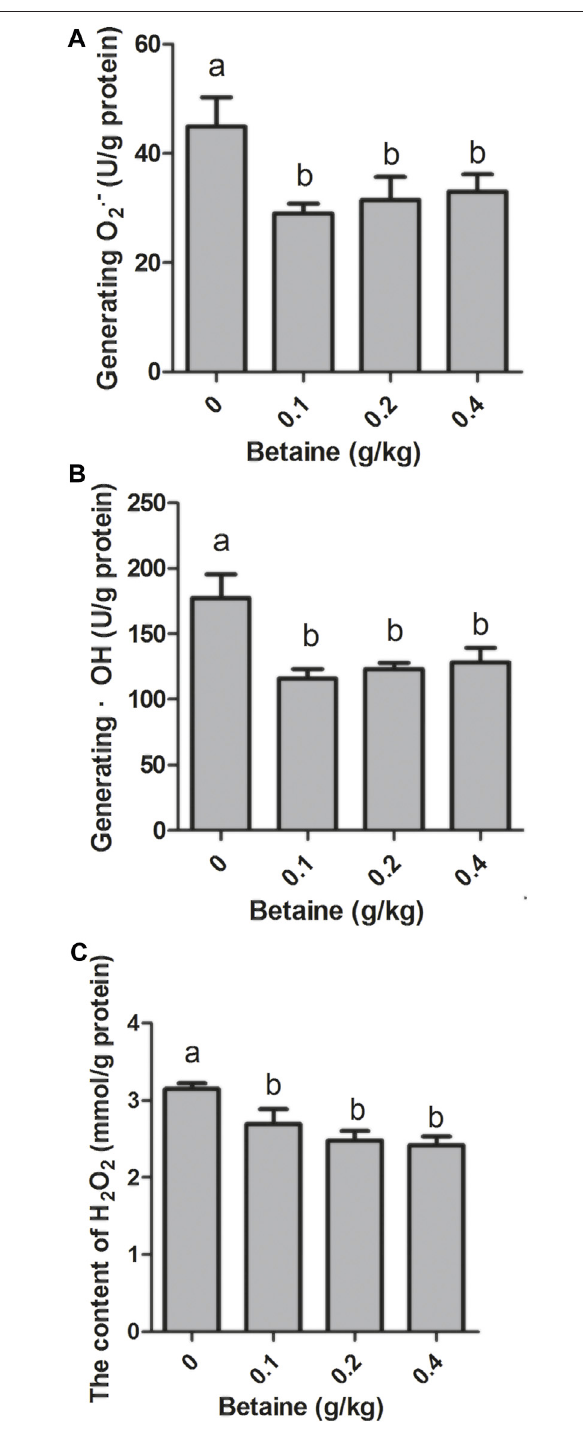
FIGURE 3 | Effect of betaine on the level of ROS in the liver of zebra fi sh. (A) The level of O 2 · − ; (B) The level of · OH; (C) The level of H 2 O 2 . Values are expressed as means ± sem ( n = 3). Statistically signi fi cant differences are denoted by different letters ( p < 0.05).